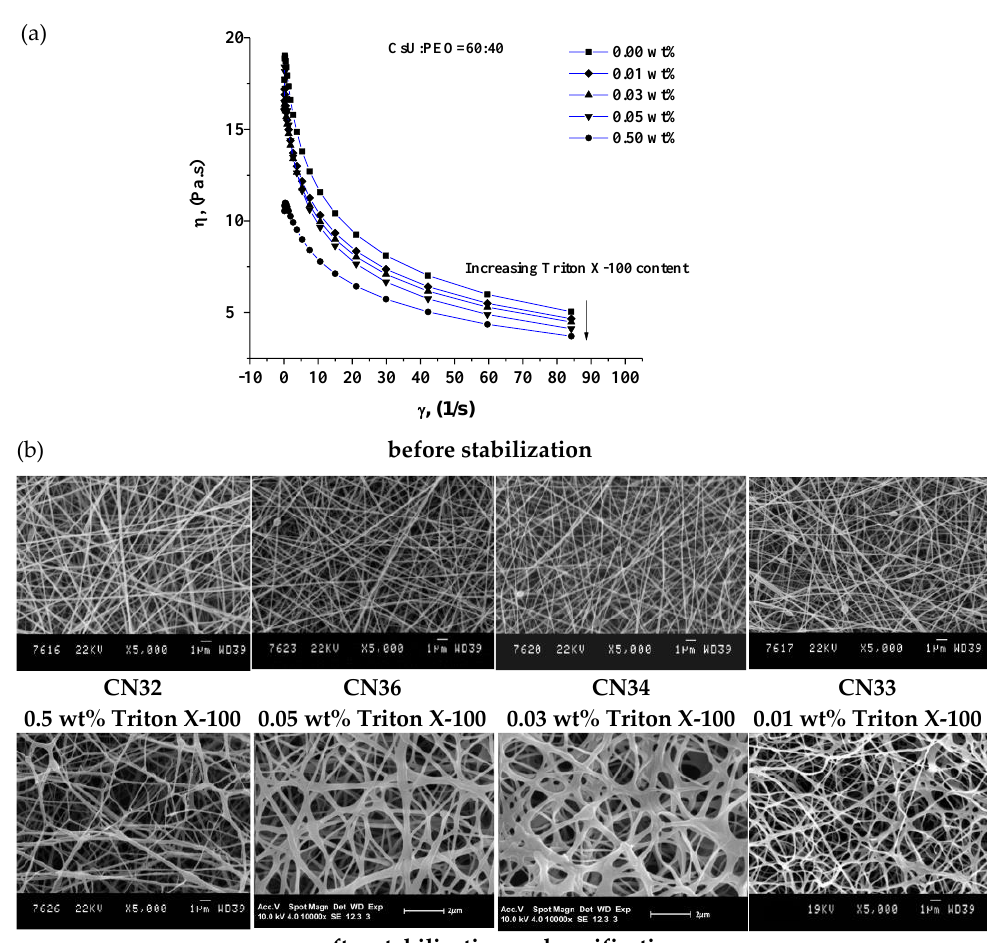
Figure 3. Viscosity vs. shear rate ( a ) and ESEM image of electrospun membranes ( b ) for solutions of the CsU1:PEO 60:40 and various contents of Triton X (see Table 3).